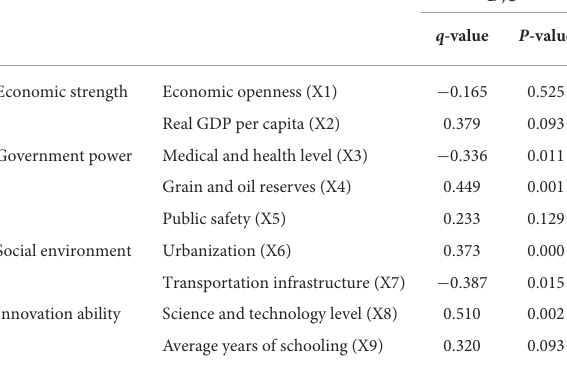
TABLE 2 Determinants of regional economic